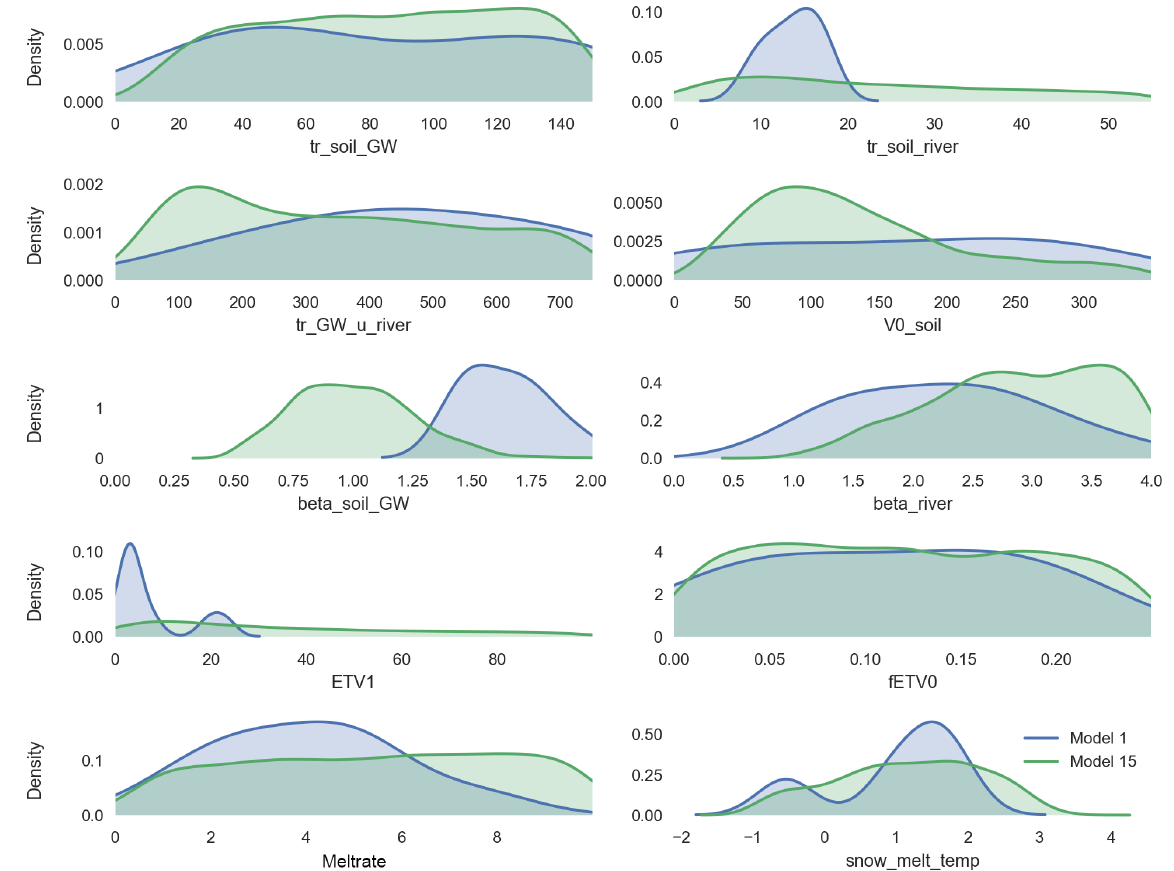
Figure 8. Distribution of all parameters shared by Model 1 (blue) and Model 15 (green), fitted with kernel